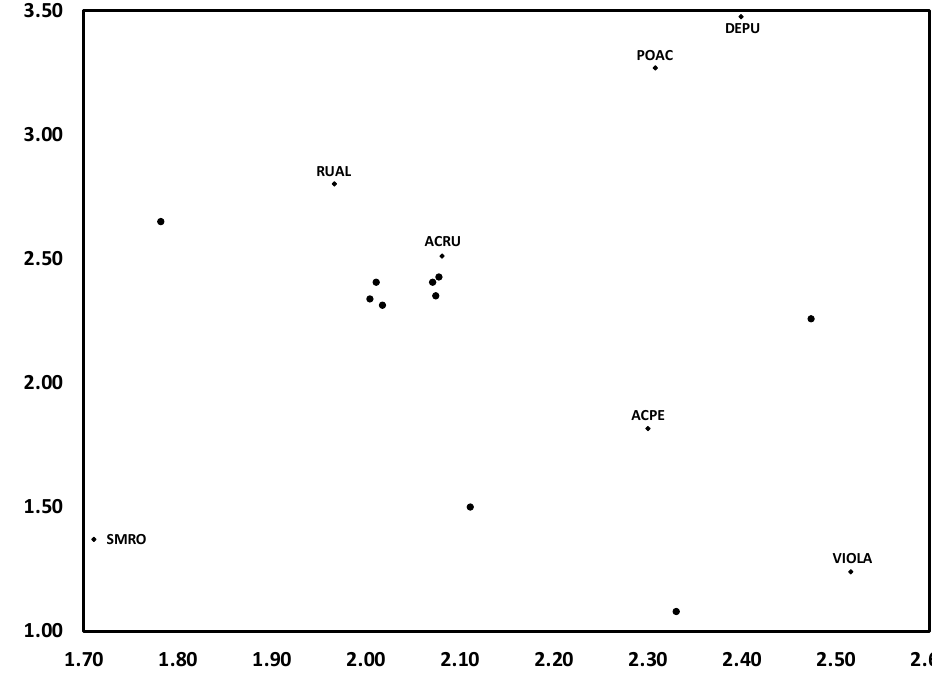
Figure 3. Detrended correspondence analysis (DCA) for herbaceous layer communities from 1991 to 2014 on N-treated WS3. Data points shown along with years are centroids (two-dimensional means) for each year per watershed.